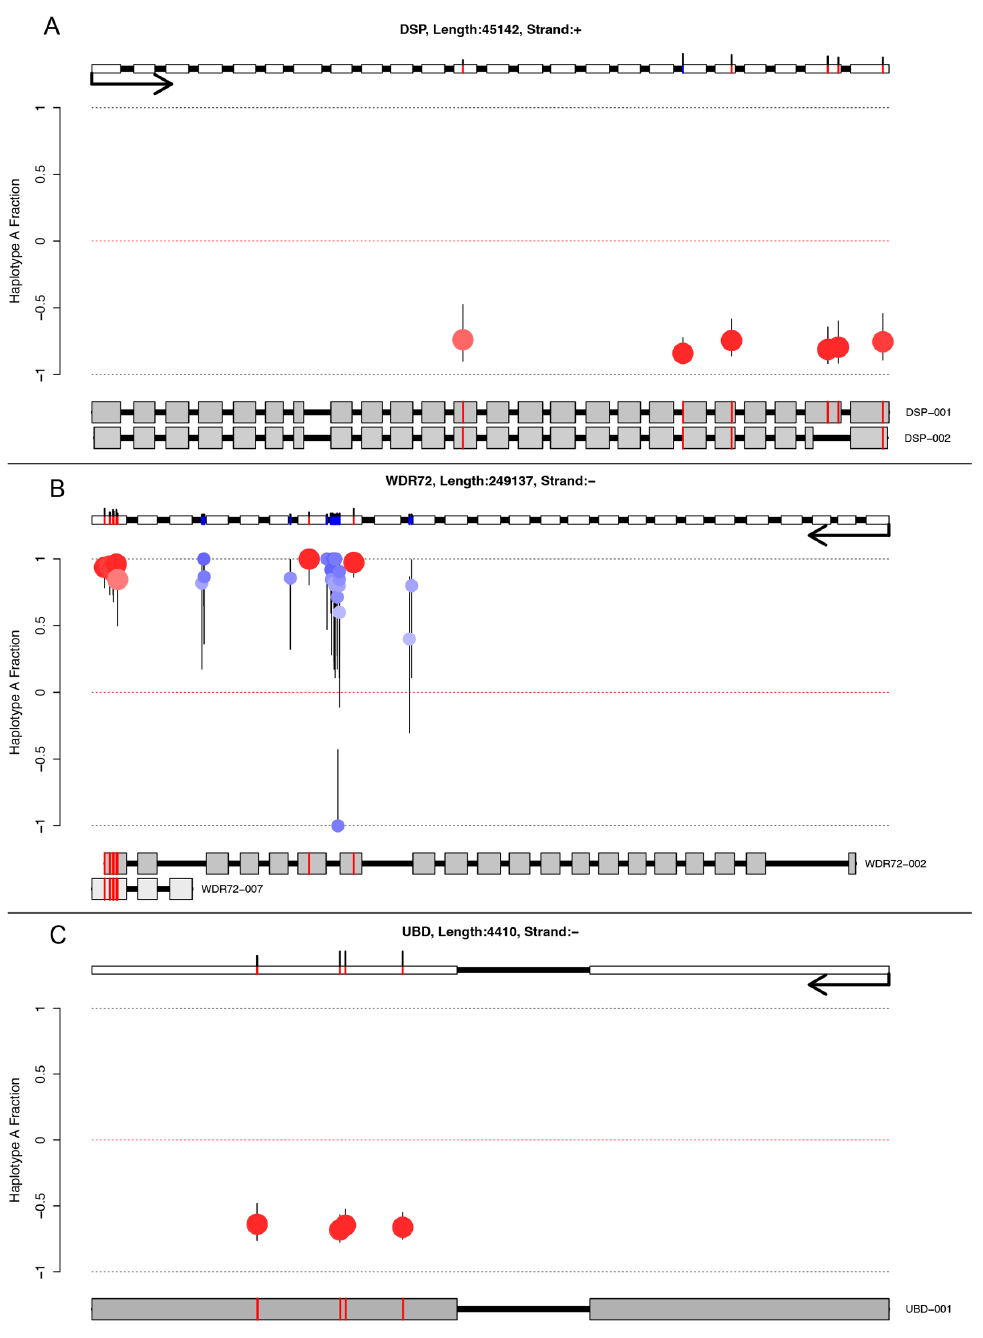
Fig 6. Schematic representation of three novel ASE genes in liver tissue. Red circles are exonic SNPs, blue circles intronic SNPs. SNP colour is proportional to probability of ASE (darker is more significant). Error bars represent the 95% binomial confidence interval (Pearson-Klopper). The gene model at the top shows the exonic (red) and intronic (blue) SNPs, the black sticks above these represent the read depth (minimum height represents 10 reads, maximum height 200 or more reads). Isoform models below are ordered by expression (top highest), and coloured by expression (darker is higher expressed). Only exonic SNPs are shown on transcripts, and only transcripts with at least one testable exonic SNP are drawn. Exon lengths are drawn at log2, and intron lengths at log10. Desmoplakin ( DSP ) is shown in panel (A), WD Repeat Domain 72 ( WDR72 ) in panel (B) and Ubiquitin D ( UBD ) in panel (C). All three genes contain multiple imbalanced SNPs concordant with haplotype phase, indicating strong ASE. Multiple intronic SNPs were testable in WDR72 and also show strong imbalance, suggesting that this gene was likely transcribed from a single allele. As no intronic SNPs were testable in either DSP or UBD , we cannot determine in these cases whether these genes were subject to allele-specific transcription or allele-specific post-transcriptional